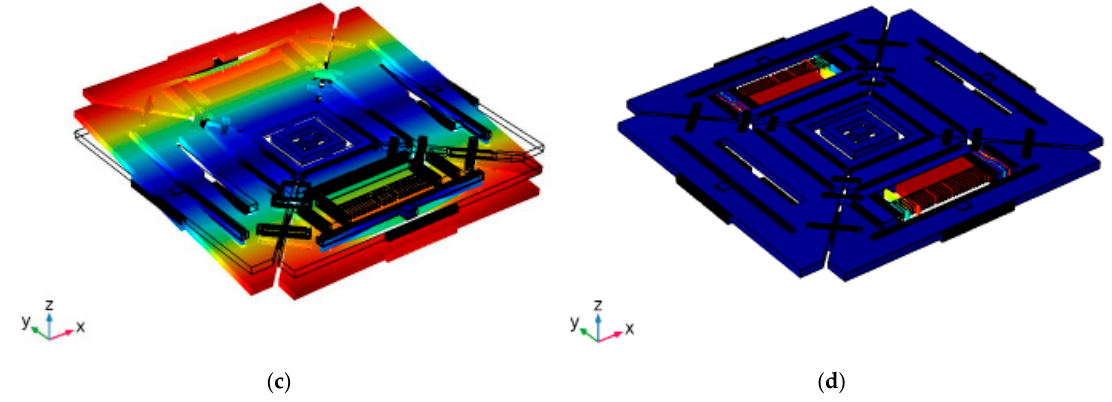
Figure 2. Simulated resonant modes of single drive multi-axis gyroscope ( a ) Lateral drive mode. ( b ) Out-of-plane X sense (Roll mode). ( c ) Out-of-plane Y sense (Pitch mode). ( d ) In-plane Z sense (Yaw mode).